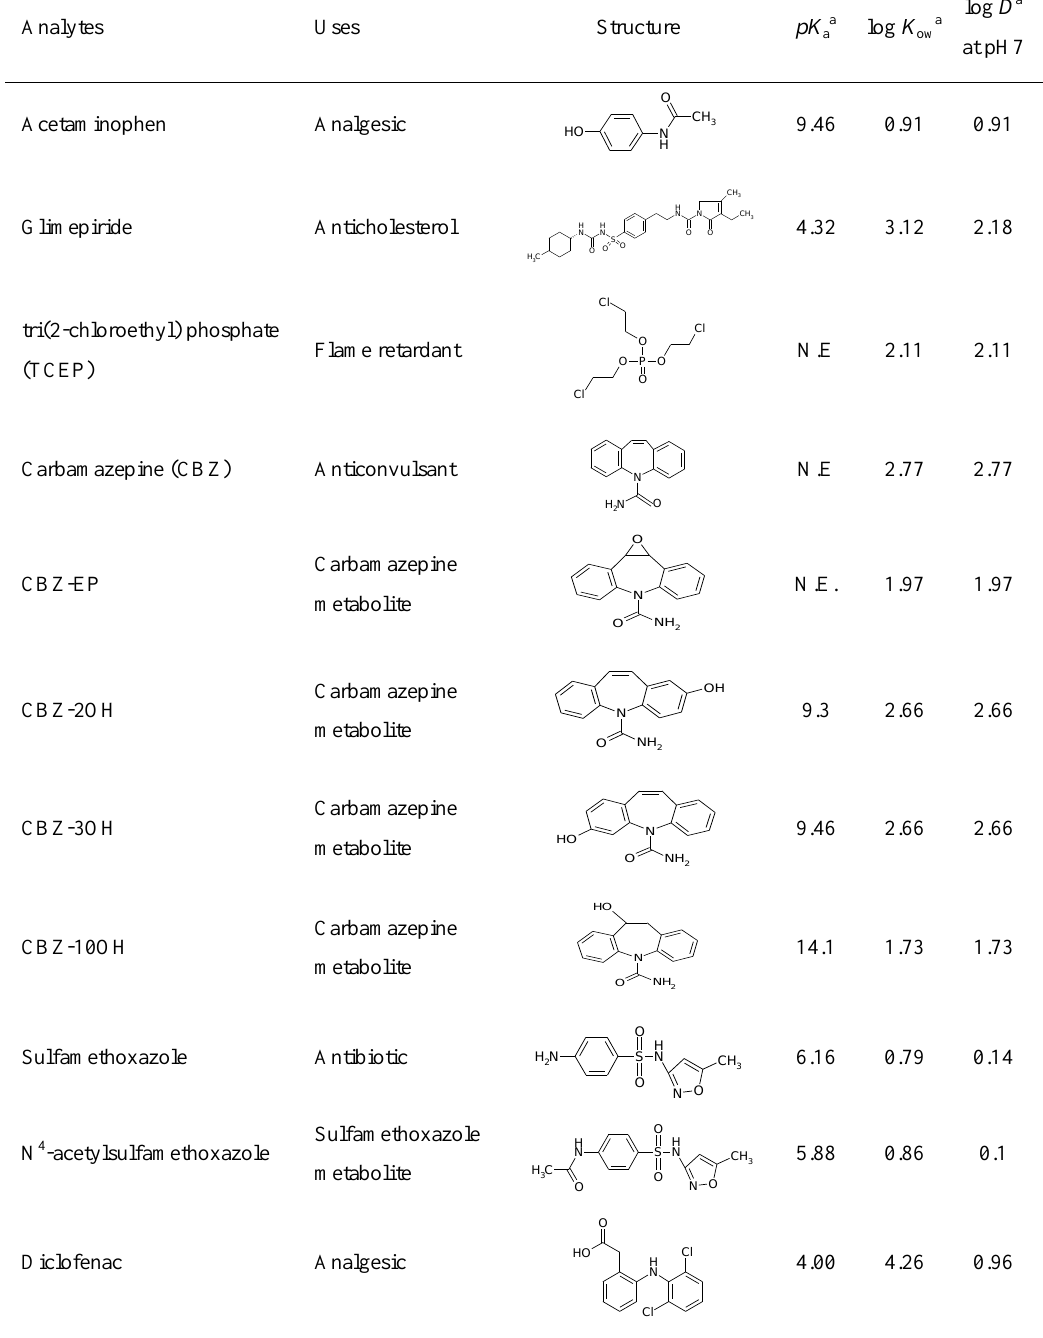
Table 1. Tested parent compounds and metabolites.